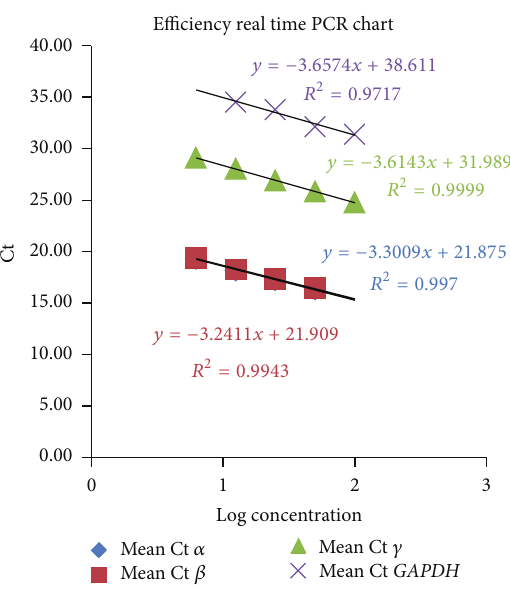
Figure 1: The standard curves of the real-time PCR